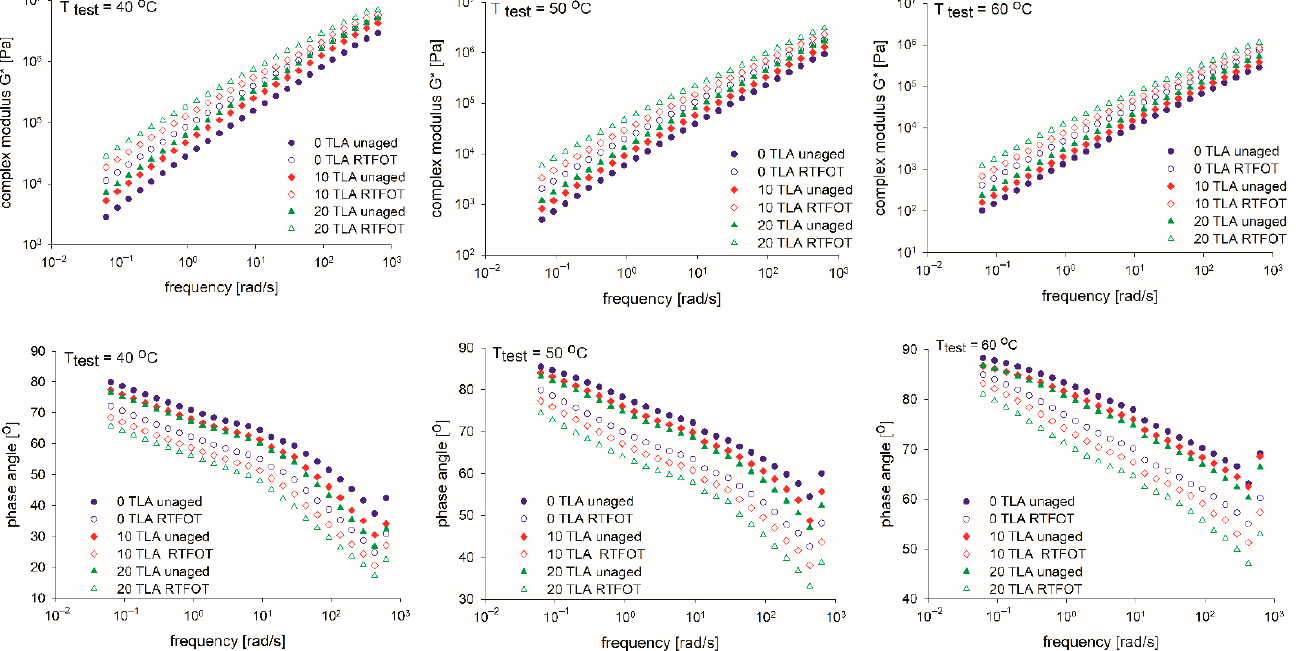
Figure 4. Isochronous curves of the complex modulus ( a ) and phase angle ( b ) of the TLA-modified binders before and after aging.